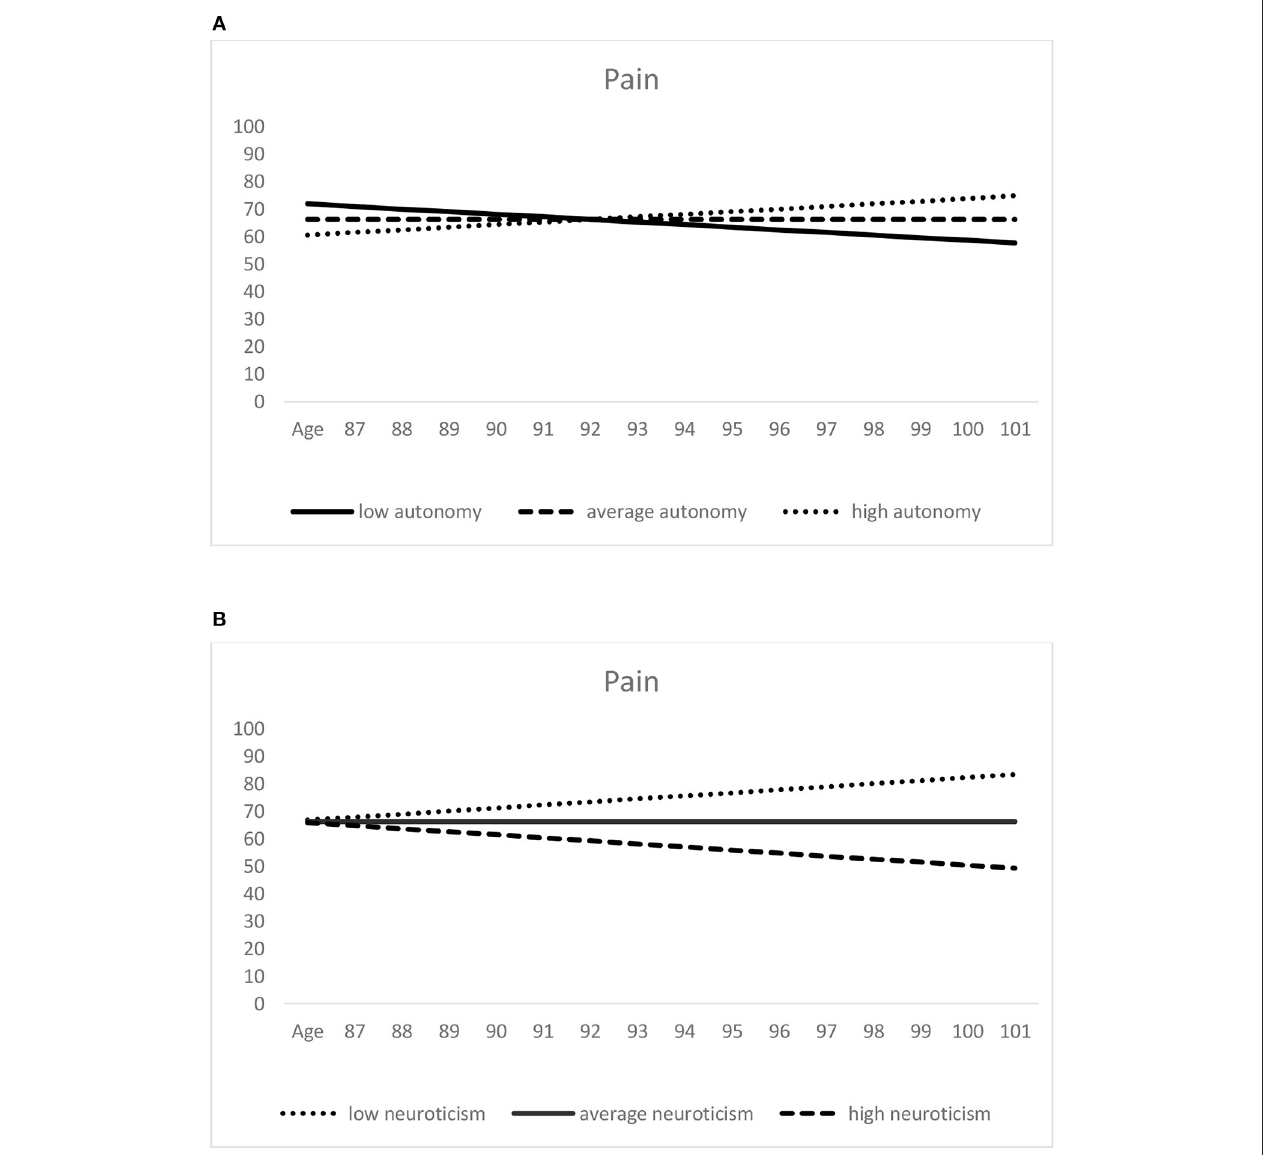
FIGURE 2 | Predictors of age-related pain trajectories: autonomy (A) and neuroticism (B) . Higher scores indicate lower pain. Low ( = one standard deviation below the mean), average ( = sample mean score), and high ( = one standard deviation above the mean) autonomy/neuroticism were derived from the scores assessed at the first measurement